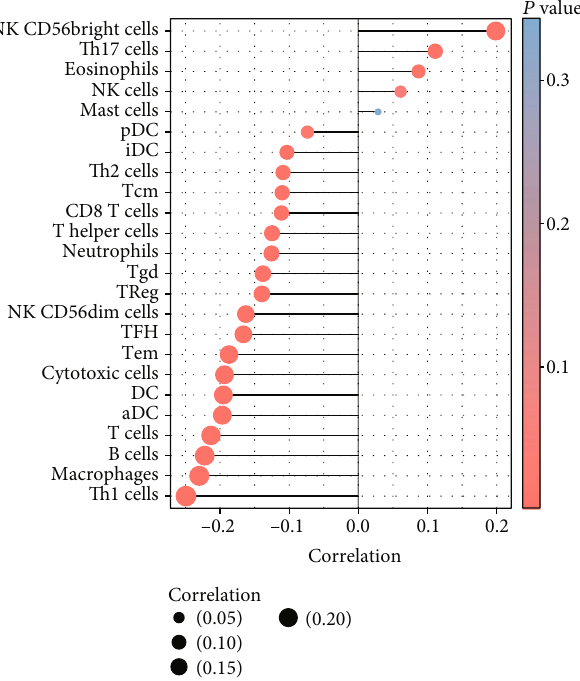
Figure 9: There was a correlation between the degree of PTK6 expression and immune in fi ltration in the BC microenvironment. The lollipop chart illustrates the correlation between the marker gene found in 24 immune cells and the expression level of the PTK6